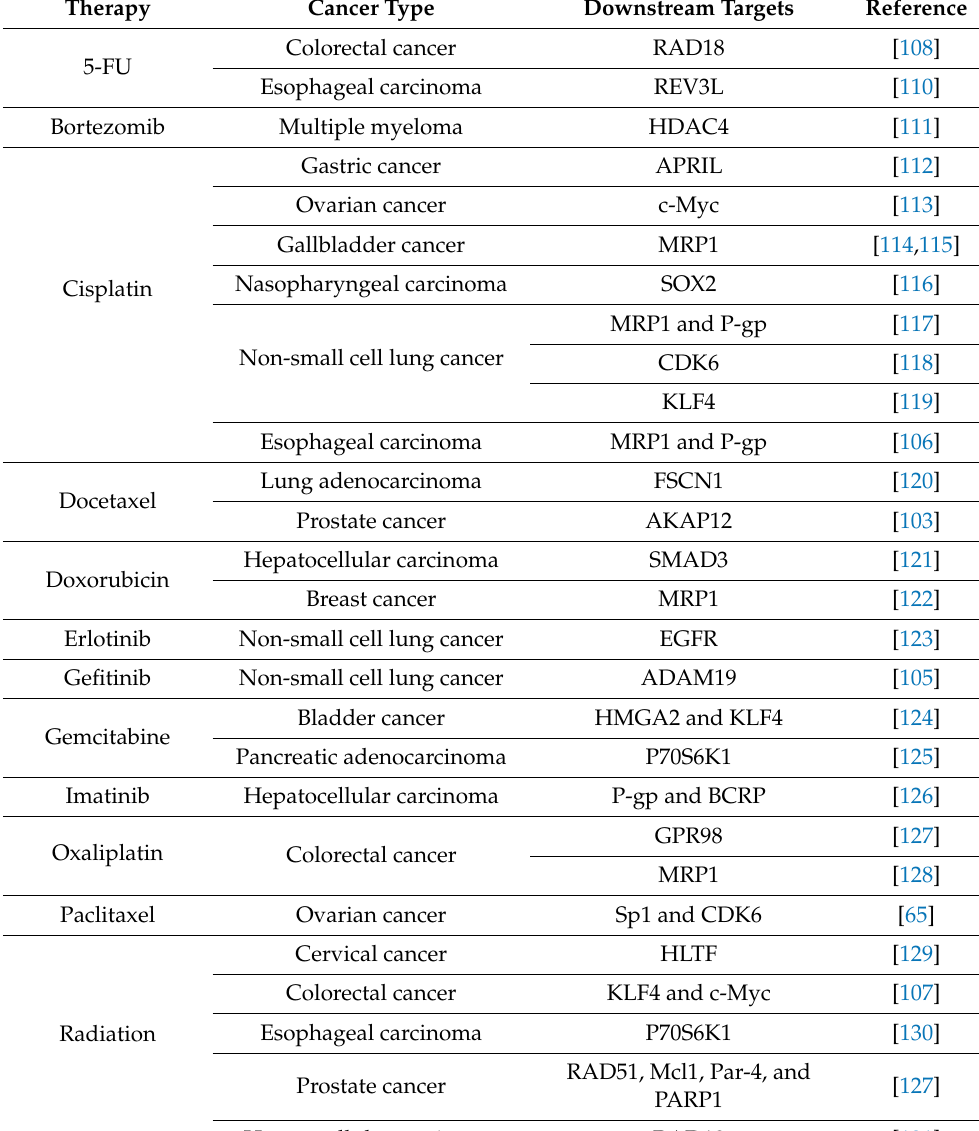
Table 5. The role of miR-145 enhances cancer therapy sensitivity and reverse